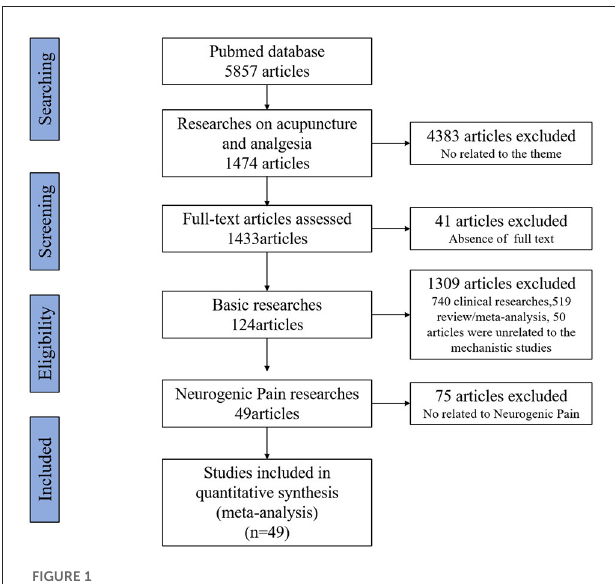
FIGURE1 Flow chart of the retrieval strategy and